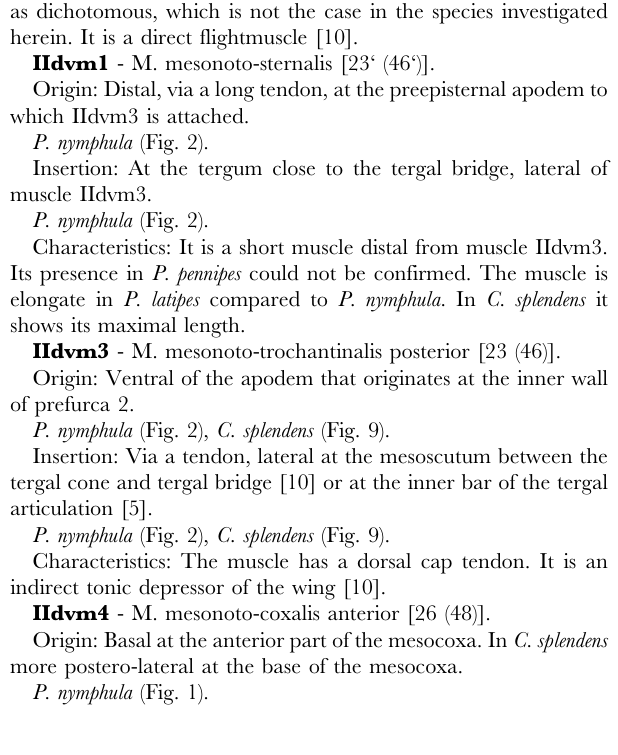
Figure 2. P.nymphula , innermost layer of thorax musculature, longitudinal cut, right. Abbreviations: A – anal vein, AxP – axillary plate, C – costa, Cu – cubitus, Cx – coxa, Fc – Furca, M – media, pCP – proximale costal plate, PEpsAp – preepisternal apodem, PFc – prefurca, PSct – prescutum, R – radius, Sc – subcosta, TAp – tergal aphophyse.